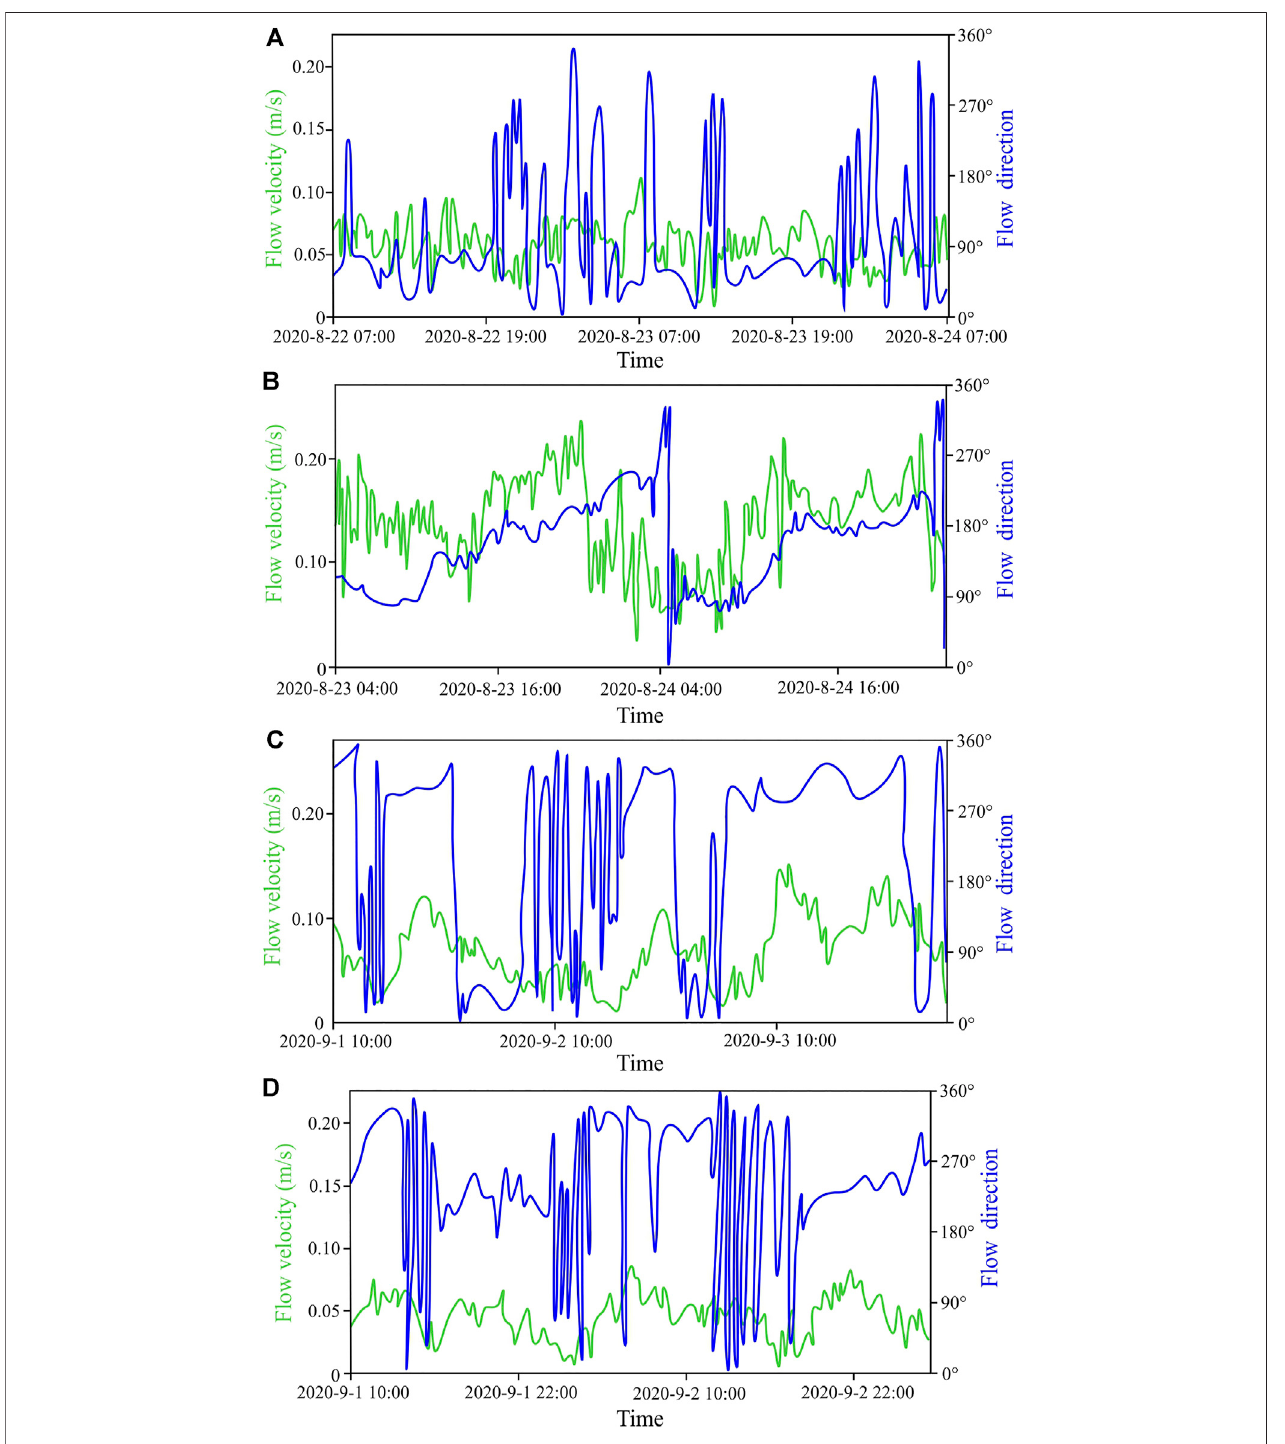
FIGURE 8 | Flow velocity and direction of the bottom currents recorded by the ADCP, including the stations of (A) C1, (B) C2, (C) C3, and (D) C4. Yellow stars indicate the ADCP stations depicted in Figure 4 .